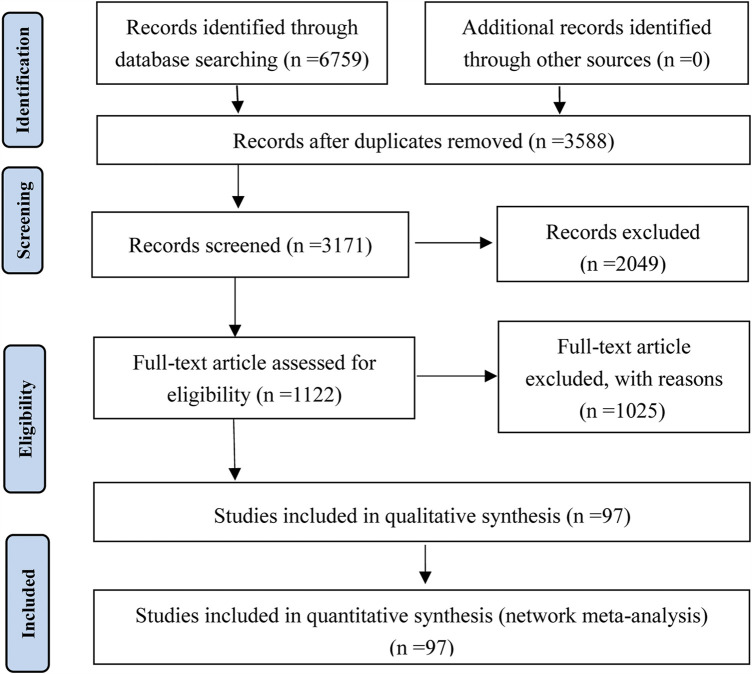
Flow chart of the search for eligible studies.